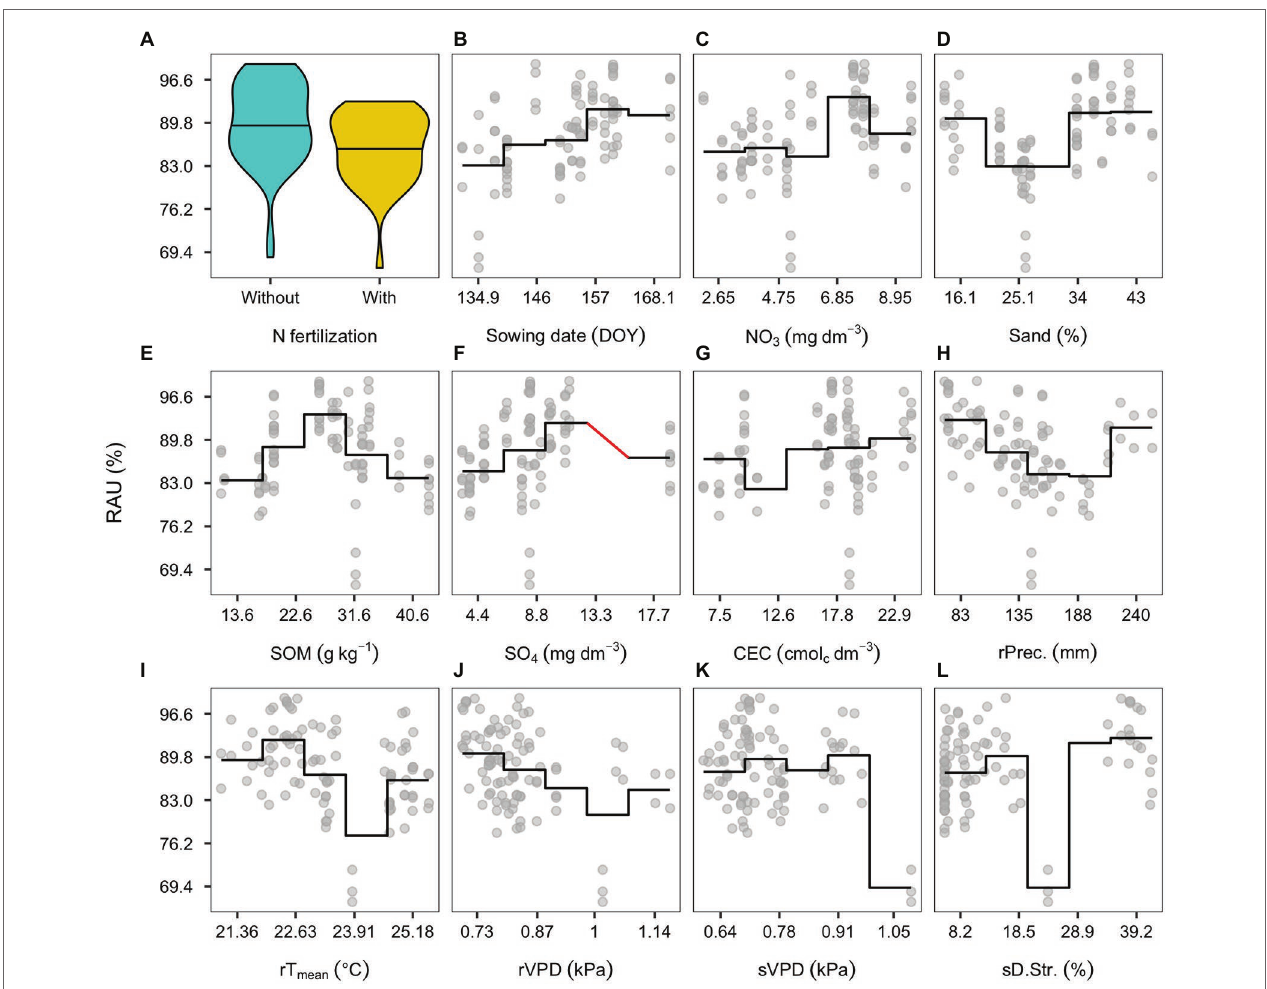
FIGURE 5 | Partial dependency plots of environmental effects affecting RAU: Nitrogen (N)-fertilization (A) ; sowing date (DOY; B ); soil nitrate concentration (C) ; sand concentration (D) ; soil organic matter (SOM; E ); soil sulfate concentration (F) ; soil cation exchange capacity (CEC; G ); precipitation during pre-seed filling (H) ; radiation during pre-seed filling (I) ; vapor pressure during pre-seed filling (J) ; vapor pressure during seed filling (K) ; drought stress during seed filling (L) . Solid lines represent a segmented mean for seven intervals comprised within the variables range. Red lines represent the absence of